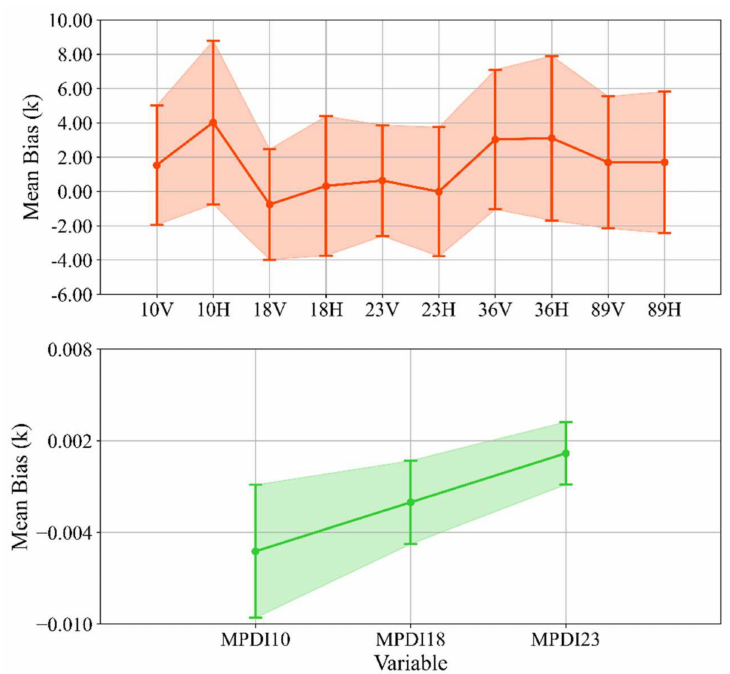
Figure 4. Mean difference of variables in the training